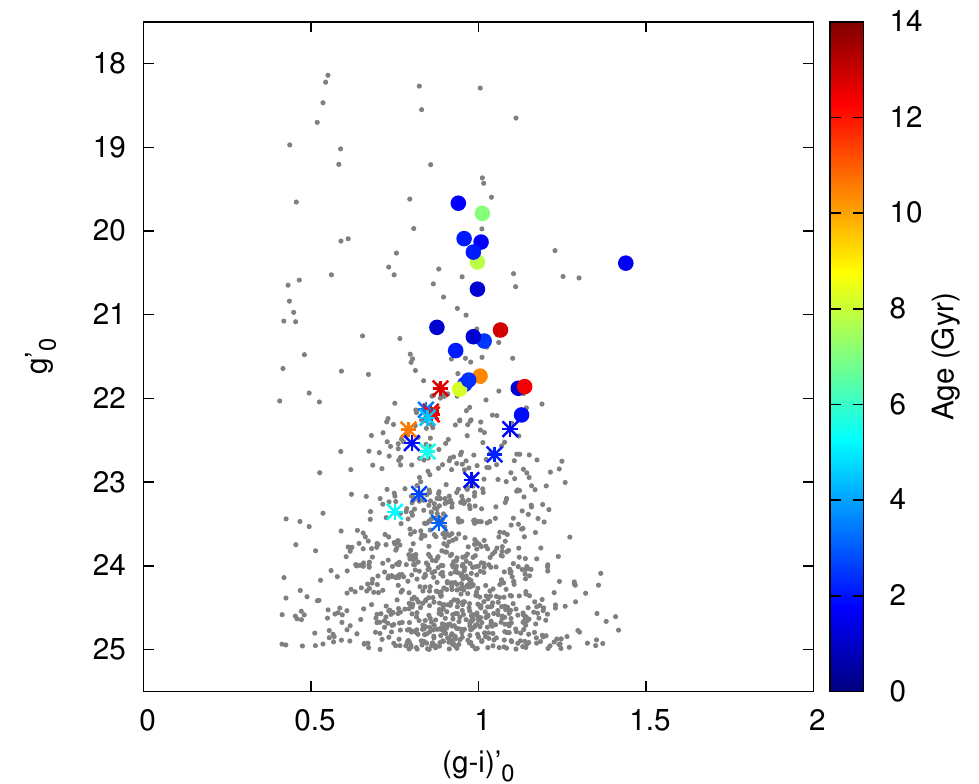
Figure 2. Color-magnitude diagram of the photometric GCs candidates ([3]). The grey dots correspond = 25mag. The colors indicate the different to the globular clusters (GCs) candidates brighter than g (cid:48) 0 ages of the of the 35 spectroscopically confirmed GCs. We distinguish between GCs with spectra with signal-to-noise ratio (S/N) <25 (stars) and S/N >25